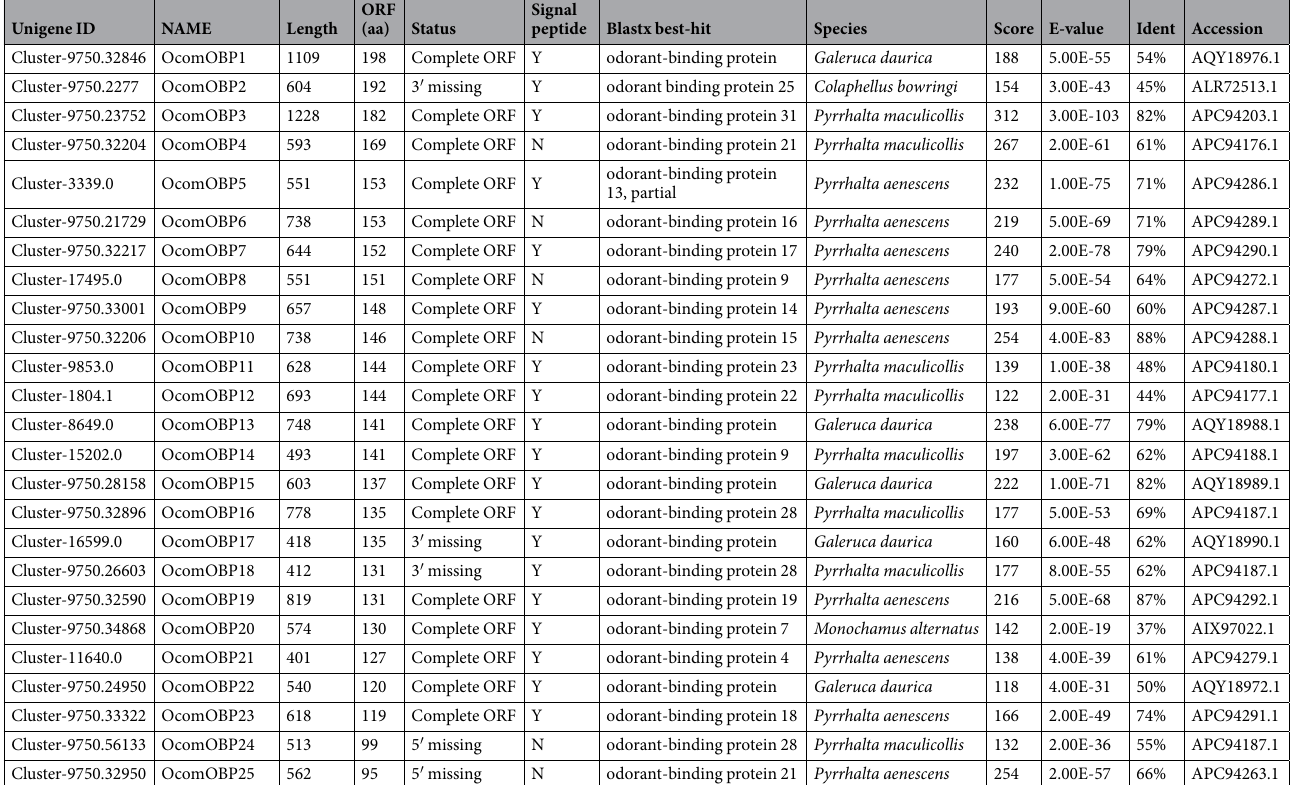
Table 2. The Blastx match of O . communa candidate candidate odorant binding